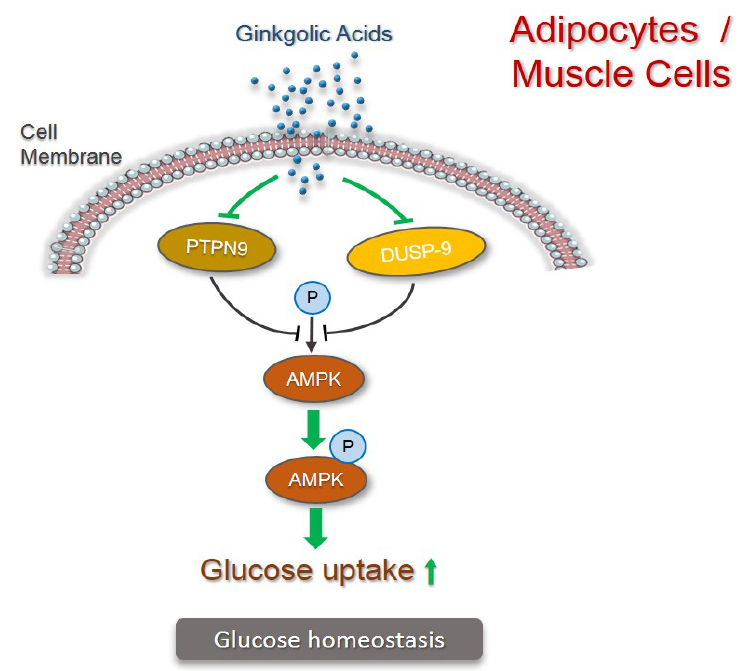
Figure 2. Mechanism for antidiabetics by ginkgolic acids in adipocytes and muscle cells. PTPN9 and DUSP9 negatively regulate the phosphorylation of AMPK (illustrated in black). Ginkgolic acids inhibit activity of PTPN9 and DUSP9, thus increasing phosphorylation of AMPK to increase glucose uptake (illustrated in green).